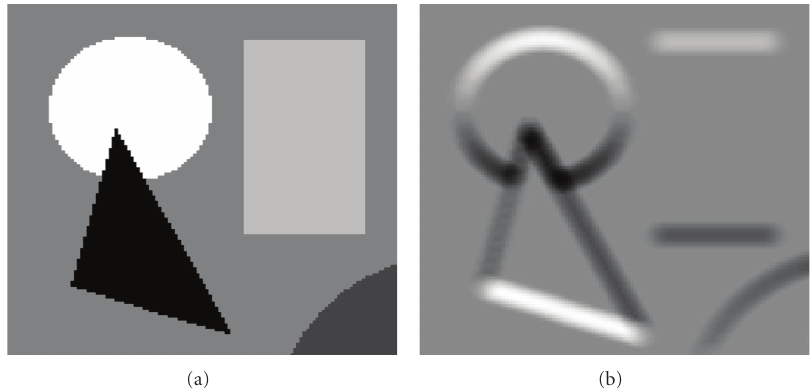
Figure 4: (a) Synthetic noiseless image. (b) Corresponding vertical component of the VSS gradient (radius = 3 for all spheres). Note there are no edge e ff ects, such as those seen with conventional gradient calculations.